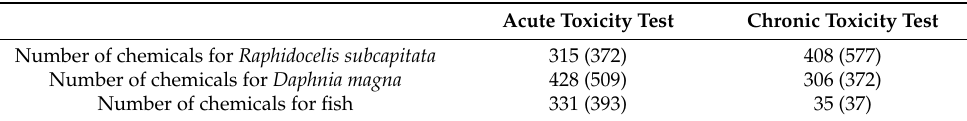
Table 2. Number of chemicals for each trophic level from acute short-term and chronic toxicity tests available in the Japanese Ministry of Environment’s database after pruning of chemical structures and experimental values. The numbers of substances before pruning are given in parentheses.